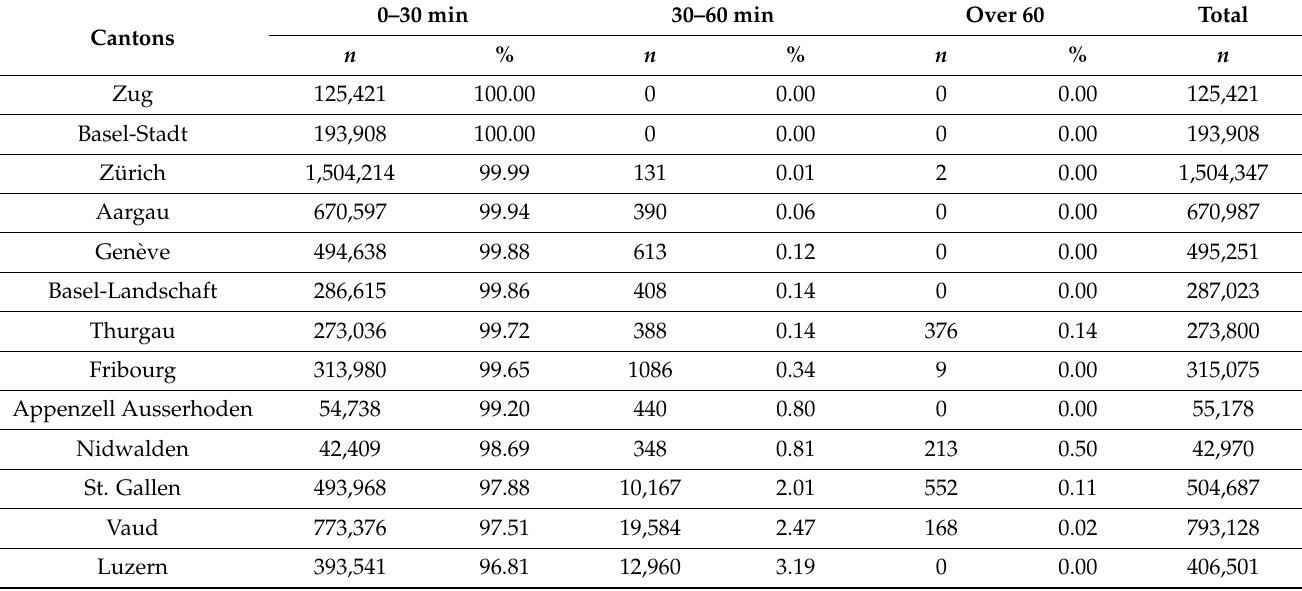
Table 4. Population living in regions with different driving times from the specialized palliative care services across cantons in